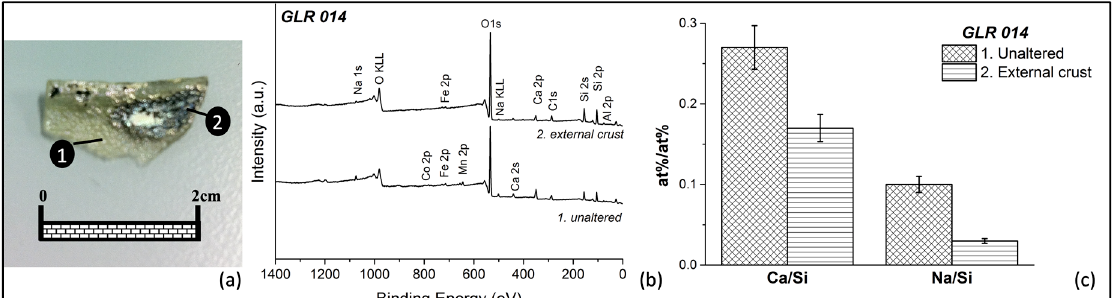
Figure 9. ( a ) The analyzed areas in sample GLR014 show the regions where the XPS spectra were collected; the corresponding X-ray photoelectron survey spectra acquired on the two different areas with a monochromatic Al K α X-ray source are shown in ( b ) together with the surface cations-to-silicon ratios ( c ).